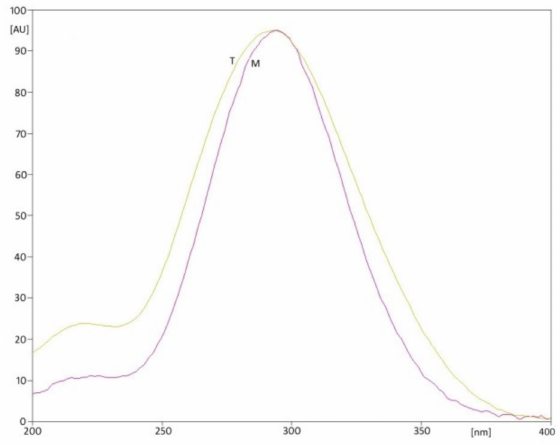
Figure 5. Absorption spectra for methanolic solutions of standard substance (M) and tablets contain- ing metronidazole